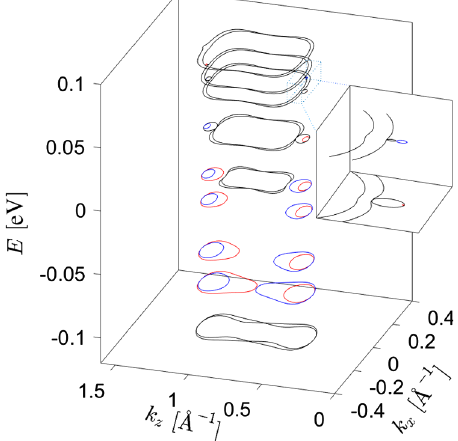
FIG. 11. Fermi surface of ZrTe at different energies. We assign a topological charge to each surface defined for an infinitesimal magnetic field in the z direction. Red (blue) corresponds to Chern number þ 1 ( − 1 ) and black is Chern number 0. The inset is a zoom-in of the second- and third-highest energies